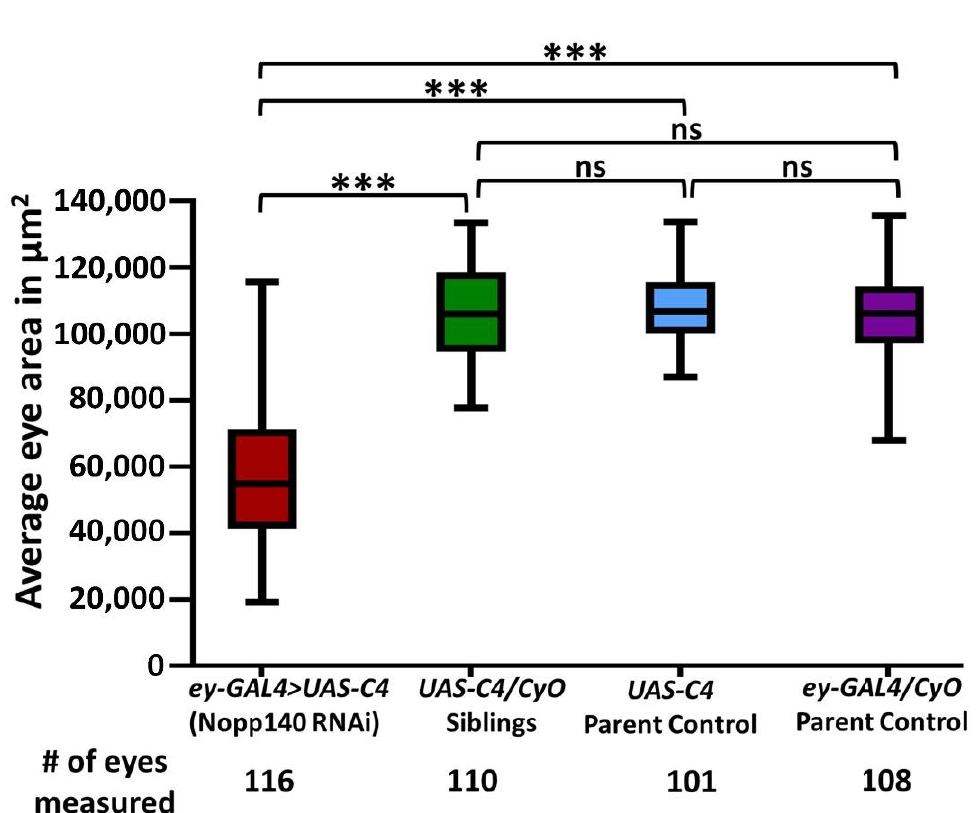
Figure 1. Decrease in eye size due to nucleolar stress generated by the expression of Nopp140-specific RNAi in the eyeless ( ey ) pattern. ey-GAL4/CyO flies were crossed to homozygous UAS-C4 flies at 27–28 ◦ C for efficient knockdown of Nopp140. The Nopp140-RNAi expressing flies ( ey-GAL4 > UAS-C4 ) with straight wings were compared to parental types and their siblings with curly wings. Data are presented as the average eye area in µ m 2 of all scored flies. The total number of eyes and the number of individual flies scored per genotype are listed at the bottom of the graph. Statistical significance was calculated by an unpaired Student’s t -test using GraphPad Prism 9.0.1 with p values < 0.0001 indicated as (***).